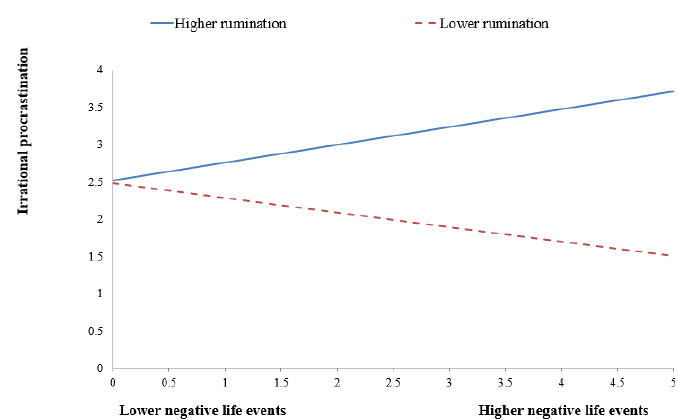
Figure 2. Rumination moderates the regression coefficient of negative life events on negative emotions in the sample of males.